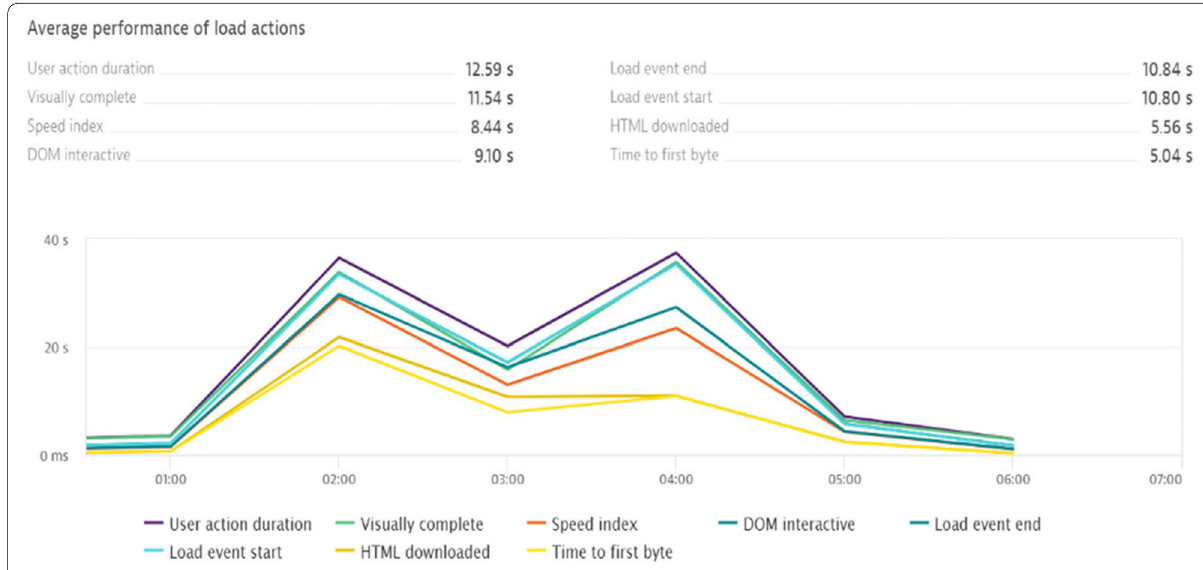
Fig. 13 Synthetic monitor performance, monolithic